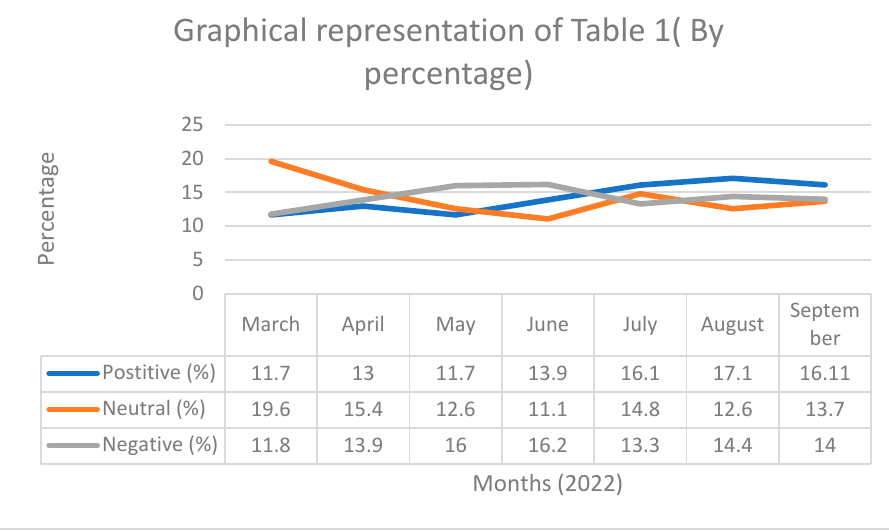
Figure 4. Graphical representation of Table 1 (by percentage).